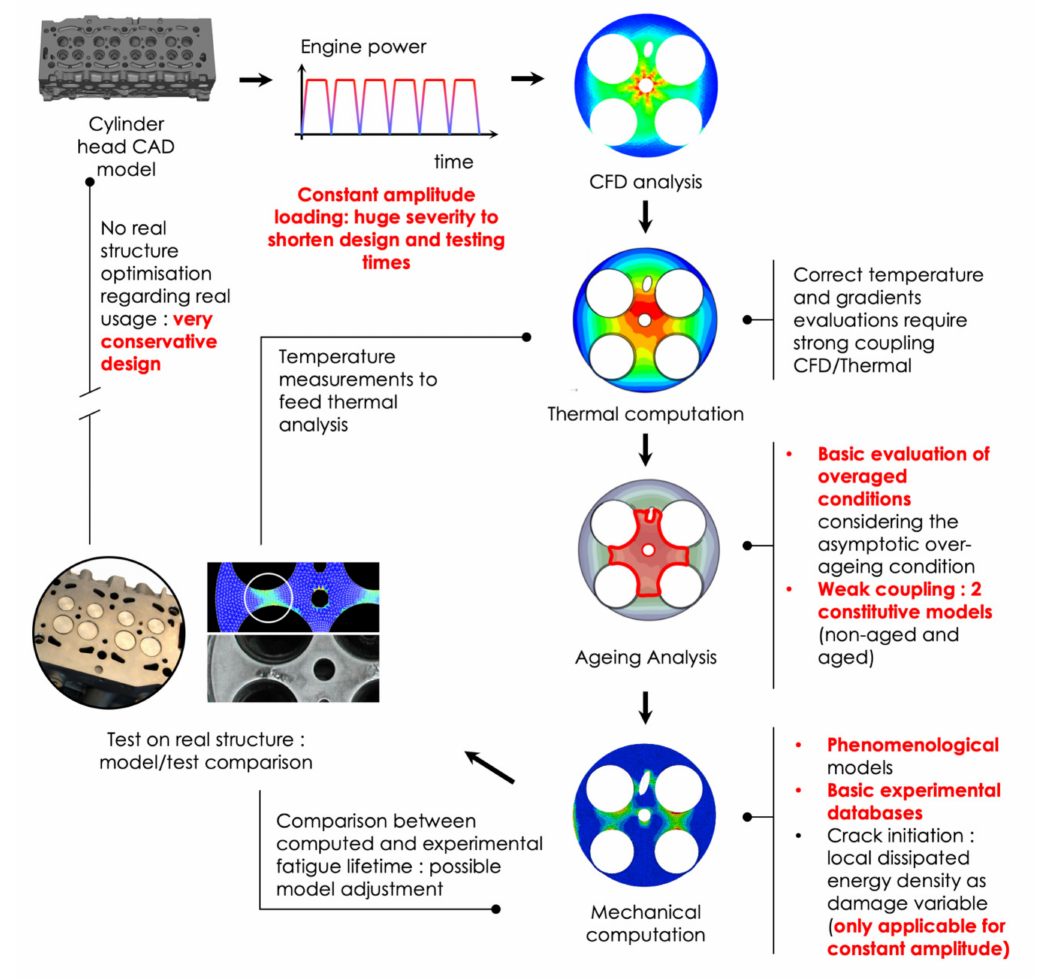
Figure 1. Global strategy for thermal–mechanical fatigue (TMF) design protocols and main weakness (in red) with focus on the fire deck as the main critical zone for TMF (CAD is for Computer Aided Design and CFD is for Computed Fluid